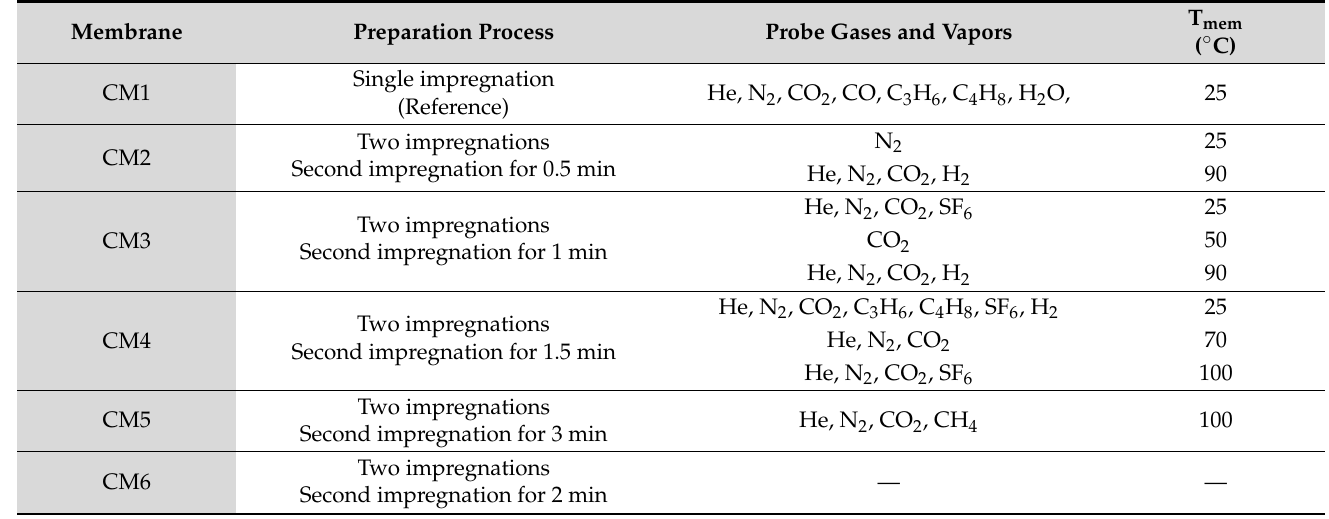
Table 2. The developed Carbon/Vycor ® membranes with their abbreviations, employed probe gases, and temperatures (T mem ) of the gas permeation